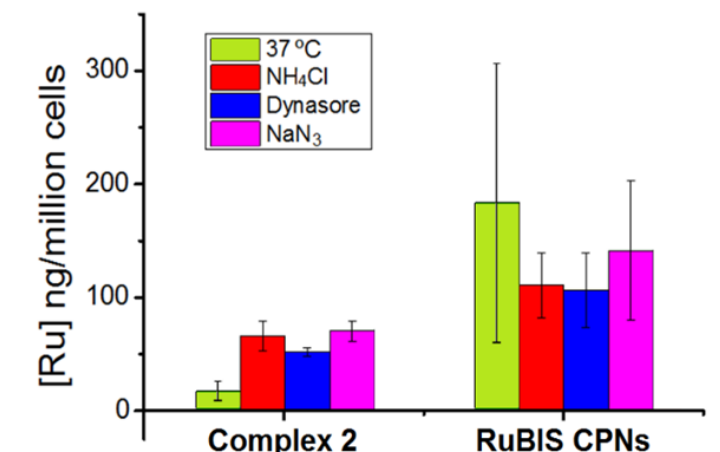
Figure 6. Cellular uptake quantification for Ru content in A431 cells treated with complex 2 (19 μg/mL) or RuBIS CPNs (25 μg/mL) nanoparticles for 2 h in the presence or absence of uptake in- (19 µ g/mL) or RuBIS CPNs (25 µ g/mL) nanoparticles for 2 h in the presence or absence of up- hibitors: ammonium chloride, dynasore, or sodium azide endocytosis. take inhibitors: ammonium chloride, dynasore, or sodium azide endocytosis.